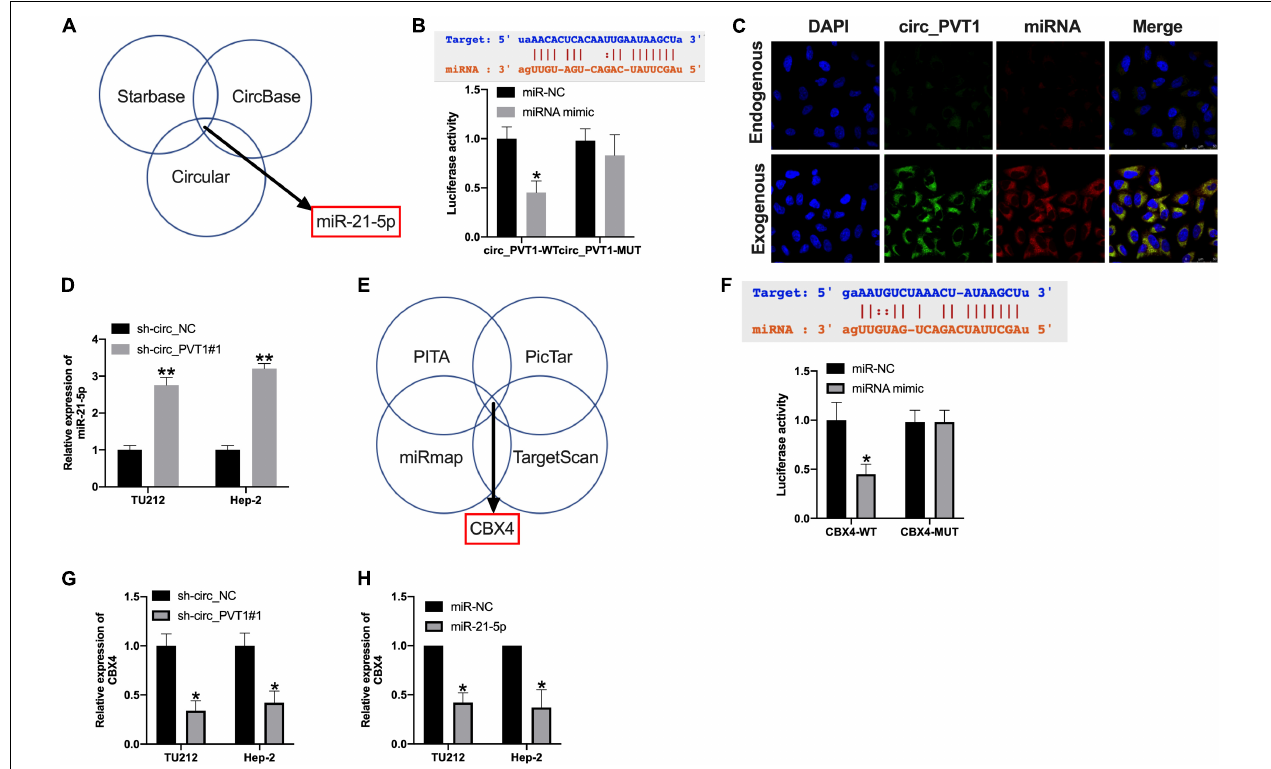
FIGURE 5 | Circ_PVT1 could target miR-21-5p and regulate CBX4. (A) Bioinformatics websites (Starbase, CircBase, and Circular) identified miR-21-5p as circ_PVT1 target. (B) The predicted binding site between circ_PVT1 and miR-21-5p (upper). The luciferase assay confirmed the relationship between circ_PVT1 and miR-21-5p (lower). ∗ P < 0.05, n = 4. (C) FISH assay confirmed the co-localization of circ_PVT1 and miR-21-5p. (D) The level of miR-21-5p was detected in Hep-2 cells after circ_PVT1 knockdown. ∗∗ P < 0 . 01, n = 4. (E) Bioinformatics websites (PITA, PicTar, miRmap, and TargetScan) identified CBX4 as a miR-21-5p target. (F) The predicted binding site between CBX4 and miR-21-5p (upper). The luciferase assay confirmed the relationship between CBX4 and miR-21-5p (lower). ∗ P < 0.05, n = 4. (G,H) The level of CBX4 was explored in TU212 and Hep-2 cells after sh-circ_PVT1 and miR-21-5p transfected. ∗ P < 0.05, n = 4.